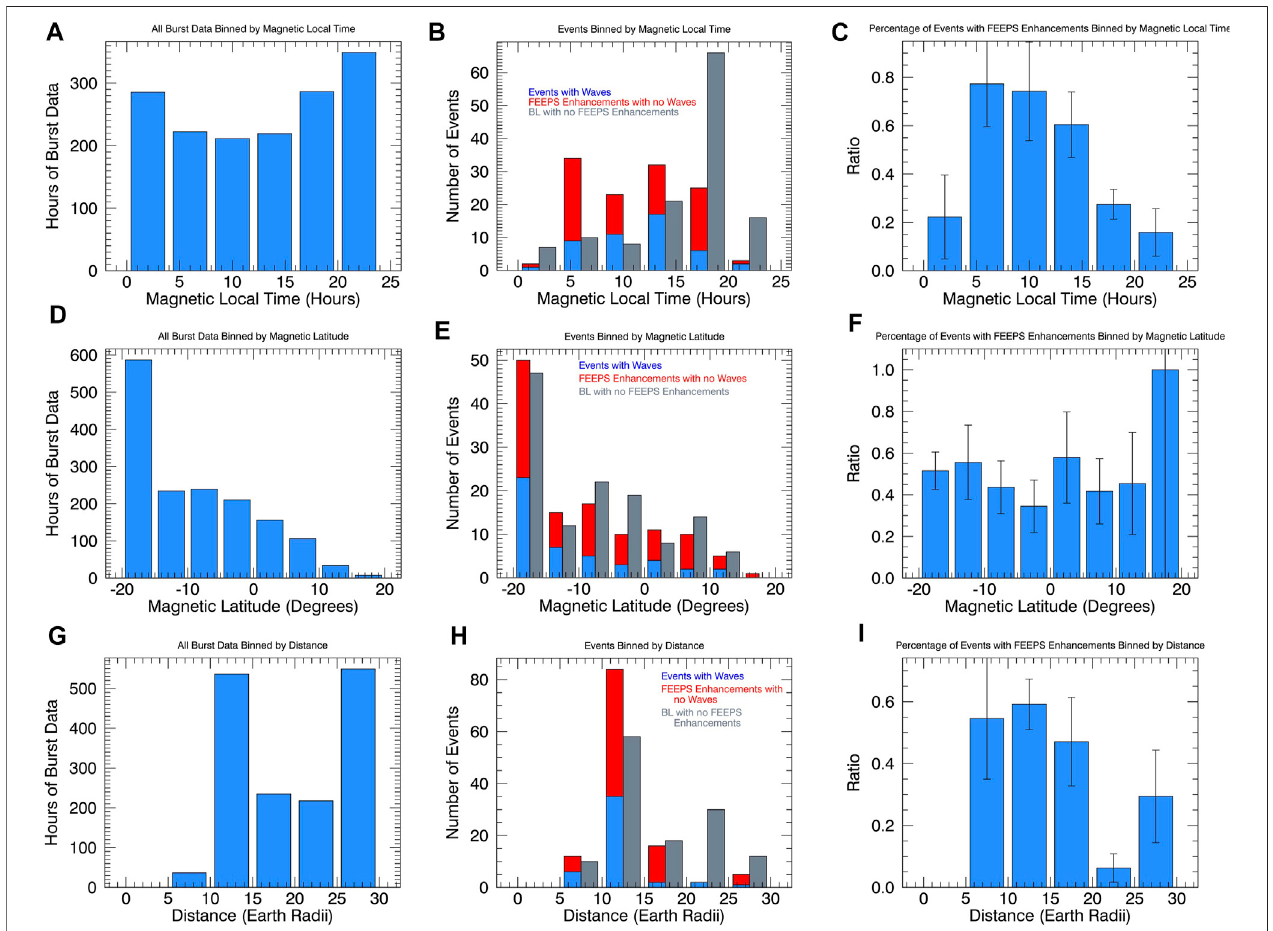
FIGURE4| Barplotscomparing boundarylayercrossingswithFEEPSenergeticelectron enhancementsandthosewithoutfordifferentparameters. Inthemiddle, the red and blue bar represents events with FEEPS enhancements (without and with whistler waves respectively) and the gray bar is crossings without FEEPS enhancements. (B) is magnetic local time, (E) is magnetic latitude, and (H) is distance. On the right is the same data graphed as percentage of total events that had FEEPSenhancements, with (C) Magneticlocaltime, (F) Magneticlatitude, (I) Distance.Ontheleftisthesame parametersforallburstdatagatheredbyMMSinthe relevant time period, with again (A) Magnetic local time, (D) Magnetic latitude, (G) Distance. Error bars derived using Poisson statistics, assuming a associated with each bin of N